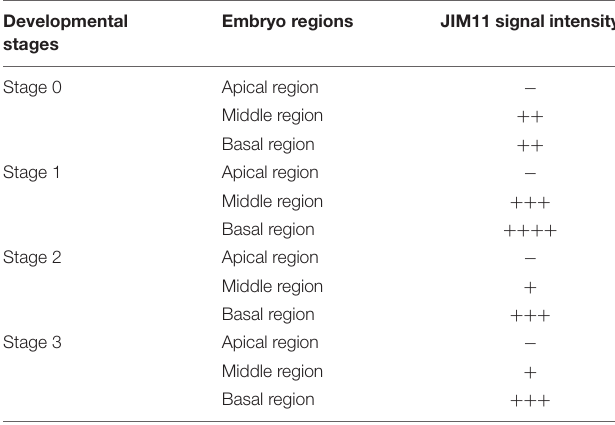
TABLE 2 | The intensity evaluation of immunofluorescence labeling with JIM11 antibody during the formation of protocorm of D. officinale in symbiotic